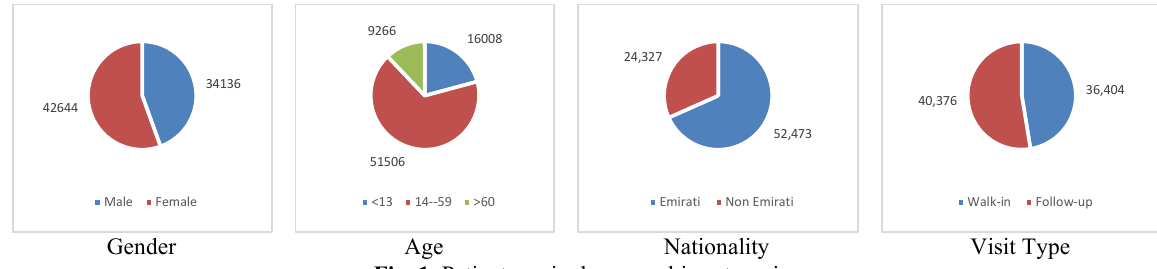
Fig. 1. Patients main demographic categories Average WT in Dubai primary healthcare centers WT